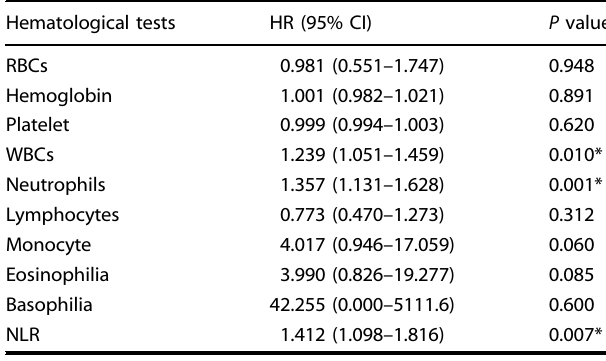
Table 5. Multivariate Cox proportional-hazards regression analyses for